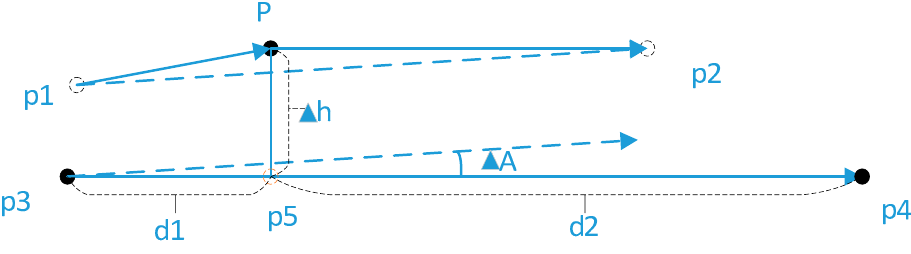
Figure 3. Schematic of merging a point into an existing road network.